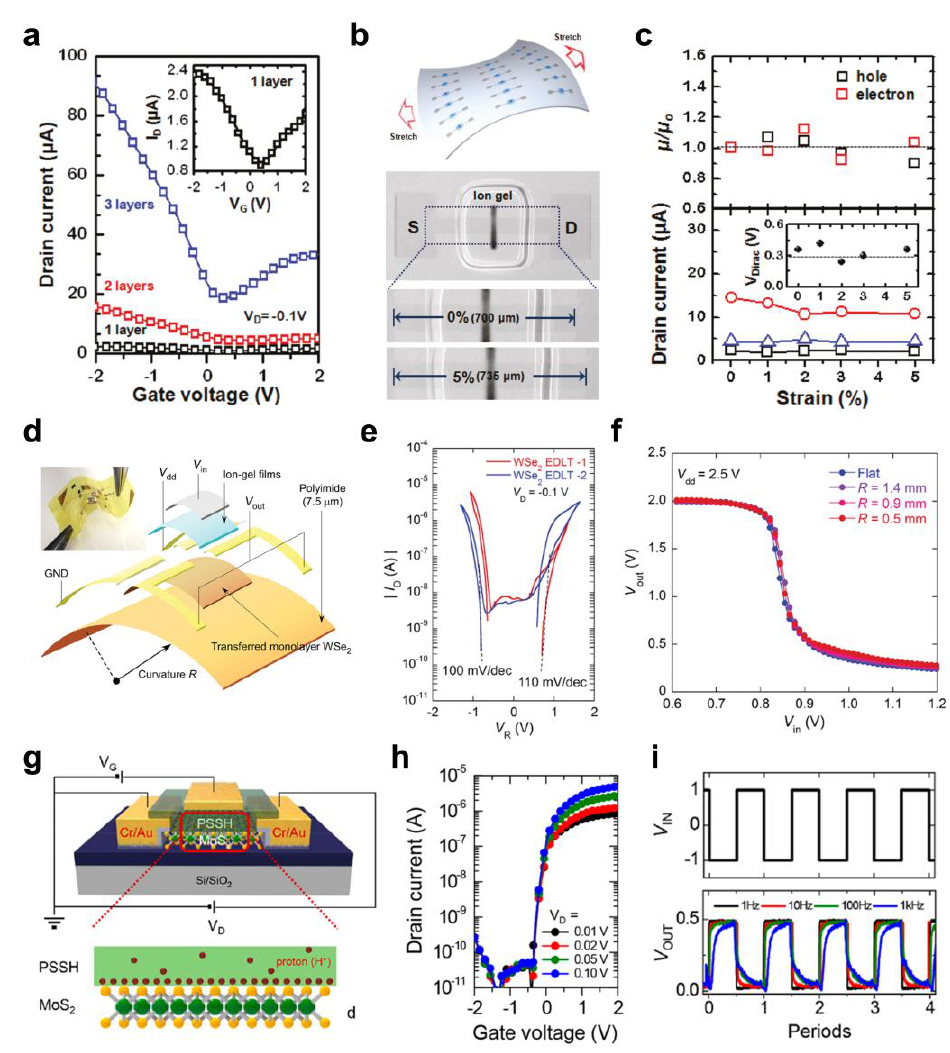
Figure 8. ( a ) The transfer curves of the graphene FETs employing [EMIM][TFSI]/PS − PMMA − PS ion gels in relation to the thickness of graphene. ( b ) Schematic illustration (top) and photography (bottom) of the stretching test. ( c ) The changes in the µ , I D , and V Dirac of the graphene FETs in relation to the applied tensile strain [135]. Copyright © 2011, American Chemical Society. ( d ) Schematic illustration (left side on the top: photography) and ( e ) transfer curves of CVD − grown 2D WSe 2 FETs with [EMIM][TFSI]/PS − PMMA − PS ion gels. ( f ) VTCs of quasi − CMOS inverter consisting of 2D WSe 2 FETs in relation to the bending radius [140]. Copyright © 2016, John Wiley and Sons. ( g ) Schematic illustration of the operating principle and ( h ) transfer curves of 2D MoS 2 FETs employing a PSSH proton conductor. ( i ) Dynamic response of a resistor − load inverter containing 2D MoS 2 FETs with PSSH with different frequencies [141]. Copyright © 2018, American Chemical